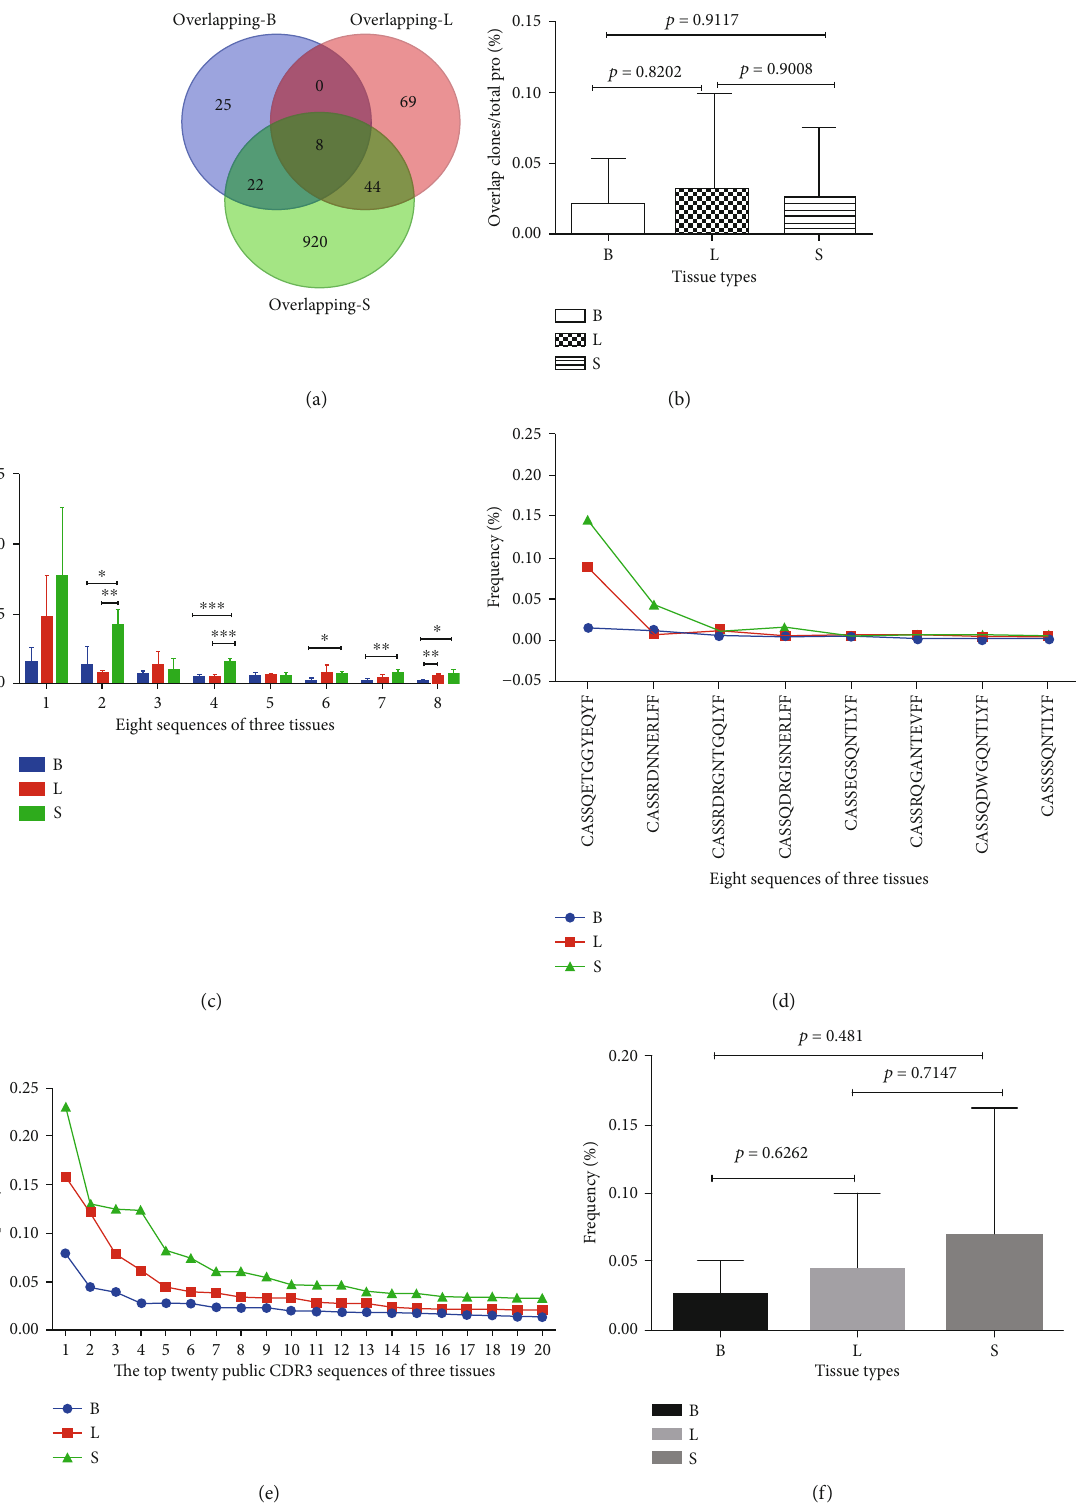
Figure 6: Total overlapped CDR3 sequences among breast tumor tissues, metastatic lung tissues, and spleens from three 4T1 tumor-bearing BALB/c mice (total of nine tissues) (a); statistical analysis comparison of the ratio of cloning proliferation of eight CDR3 sequences overlapping in nine tissues from the CDR3 repertoires: comparison of the three kinds of tissues (b); single comparison (c, d) (Supplement Table 1, ∗ p < 0 : 05 , ∗∗ p < 0 : 01 , ∗∗∗ p < 0 : 001 , n = 3 ); the distribution and proportion statistical analysis of the top 20 sequences overlapping in the three tissues were compared (e,